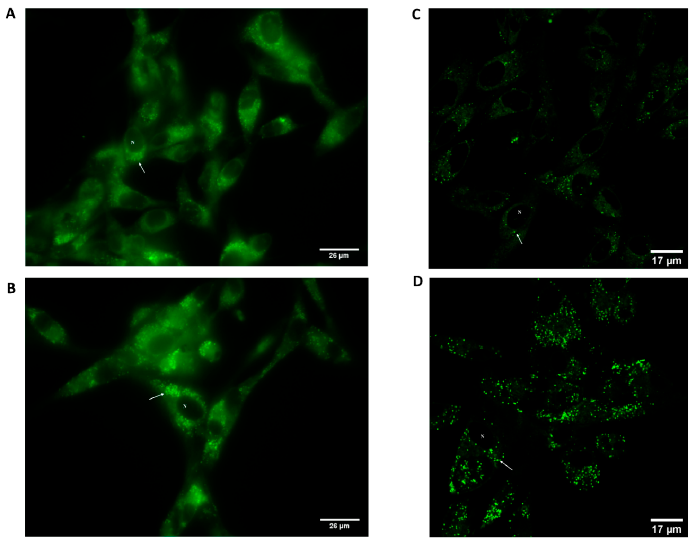
Figure 5. Biodistribution of Roy ( 1 ) isolated from Plectranthus hadiensis var. hadiensis extract in U87 cells. Cells were treated with 6.25 µ g/mL ( A , C ) and 25 µ g/mL ( B , D ) of Roy-BODIPY for 48 h. Representative images of fluorescence microscopic images ( A , B ) and confocal laser scanning microscopic images ( C , D ) show Roy-BODIPY (green fluorescence) uptake by U87 cells (Scale bar 26 and 17 µ m, respectively). Note: The cell nucleus is represented with an N and the vesicles are pointed out with a representative